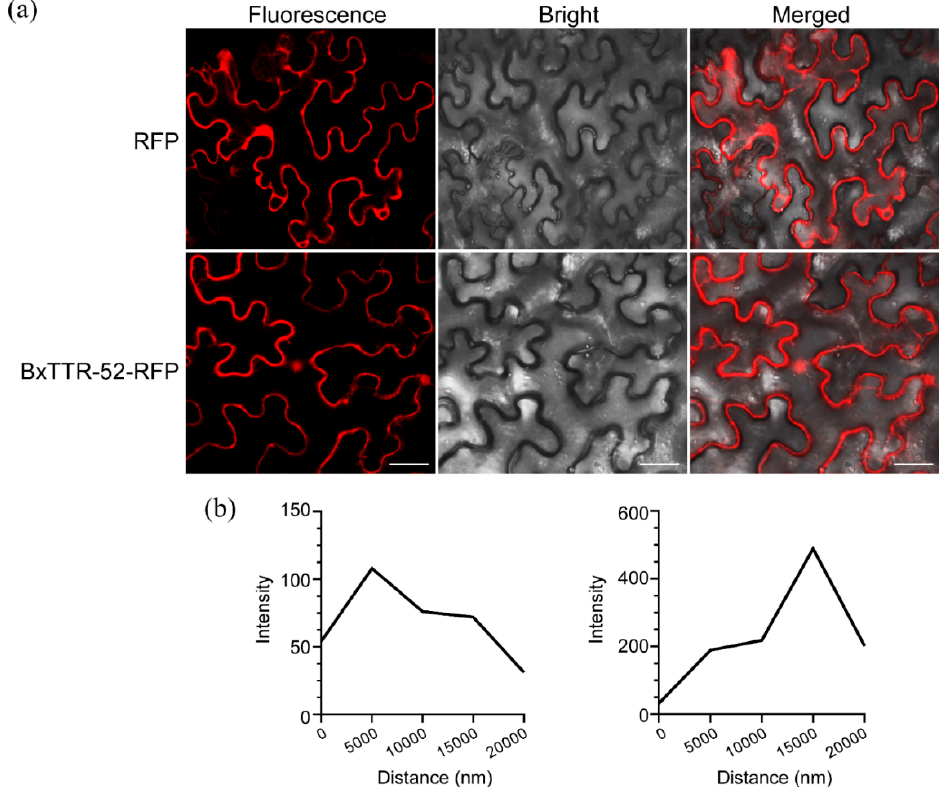
Figure 2. BxTTR-52 localized on the cytoplasm and nucleus of plant cells. ( a ) Subcellular localization of BxTTR-52 in Nicotiana benthamiana . The scale bar represents 50 µm. ( b ) The RFP intensity was delineated from the cytoplasmic and nuclear areas ( left to right ).